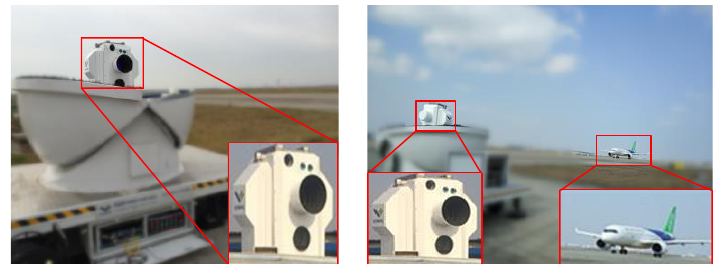
Figure 10. MVMS in the field.